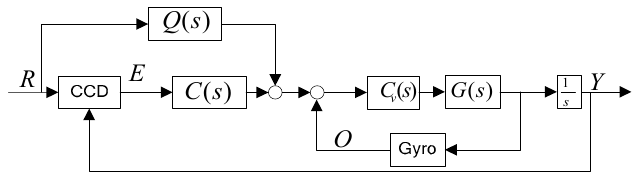
Figure 2. Classical feed forward control.